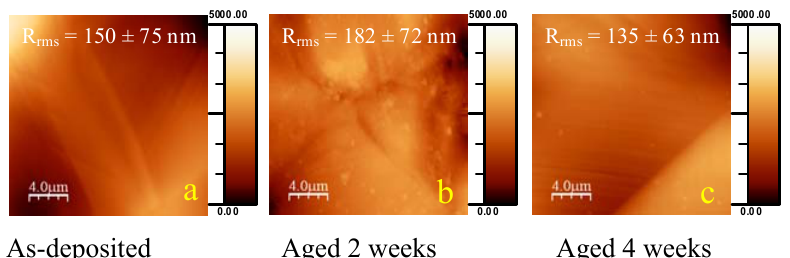
Aged 4 weeksAged 2